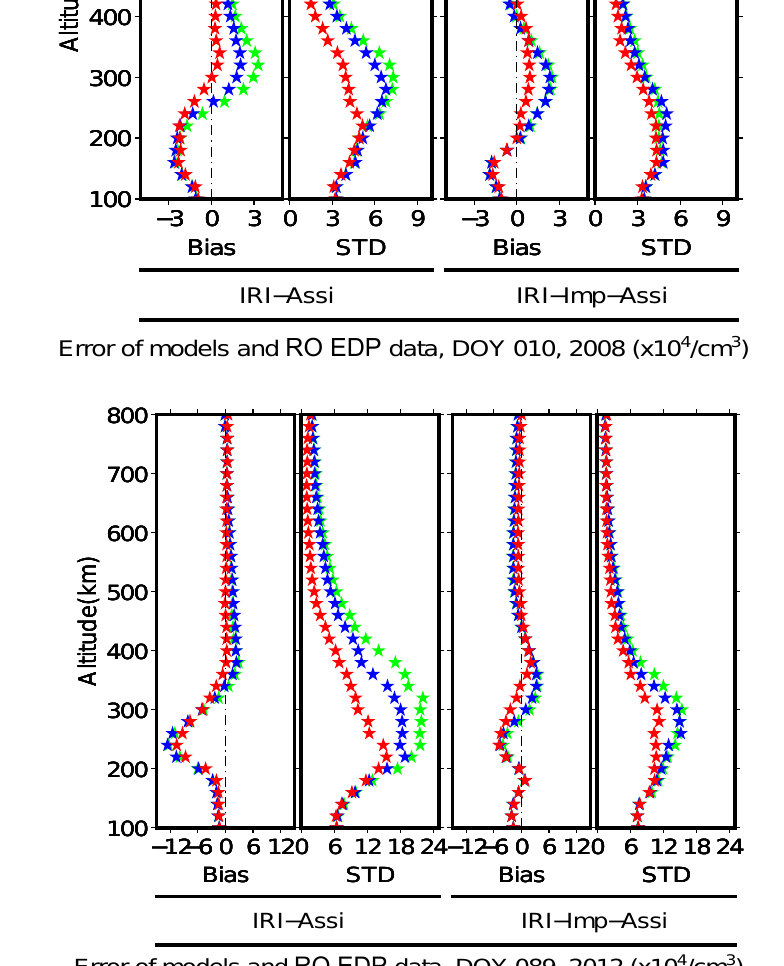
Figure 14. Biases and STDs between the initial models(the IRI and IRI-Imp models) with their assimilation models (the IRI-Assi and IRI-Imp-Assi models ) and EDP of ionPrf on DOY 010, 2008 and DOY 089, 2012: green stars, the initial models; blue star, the G+Cor strategy, only ground-based observation data with hypothesis correction; and red star, the G/S+Cor strategy, ground-based/spaceborne observation data with hypothesis